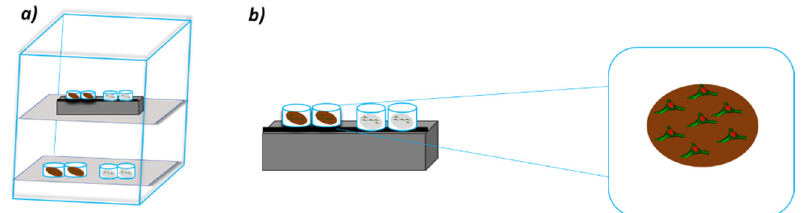
Figure 1. A scheme of the experimental setup that was employed for magnetic stimulation. ( a ) Incubator equipped with electromagnet; ( b ) further details related to cell-laden constructs and stimulation system.